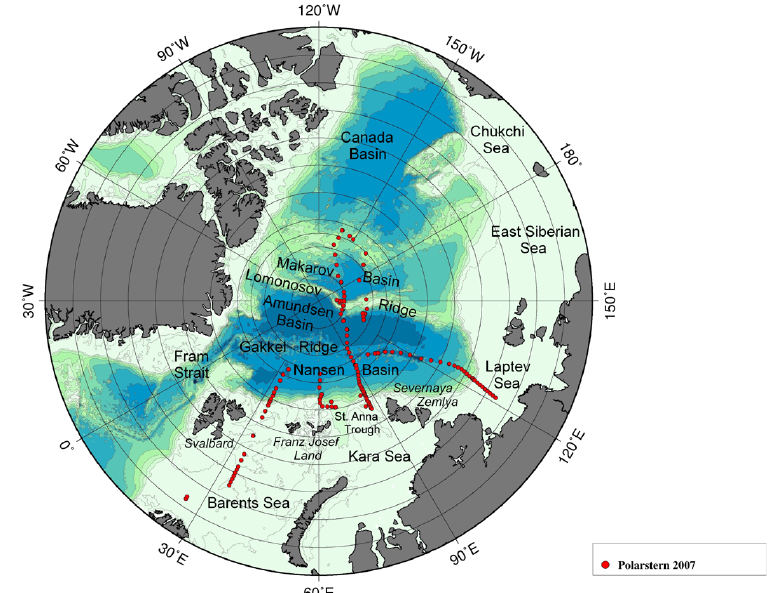
Fig. 2a. The station positions on the SPACE cruise 2007 with R/V Polarstern .